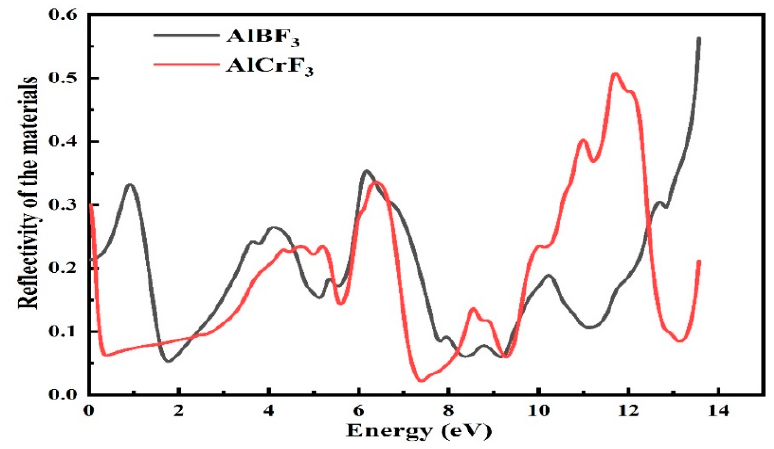
Figure 8. Calculated reflectivity coefficient R ( ω ) for compounds.